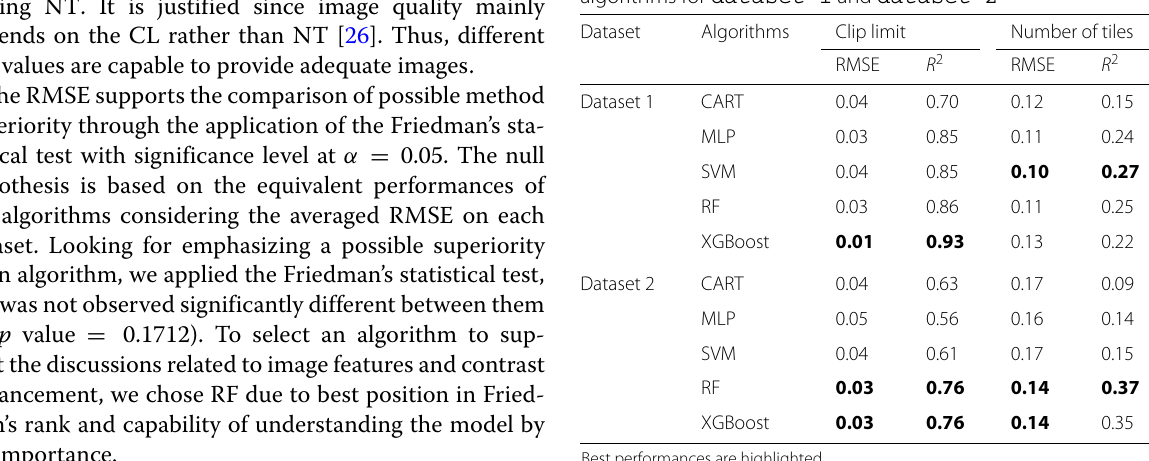
Table 4 Predictive performance of machine learning regression algorithms for dataset 1 and dataset